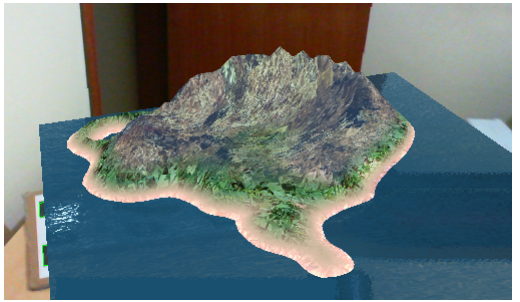
Fig. 13. Simple island created using the proposed system.